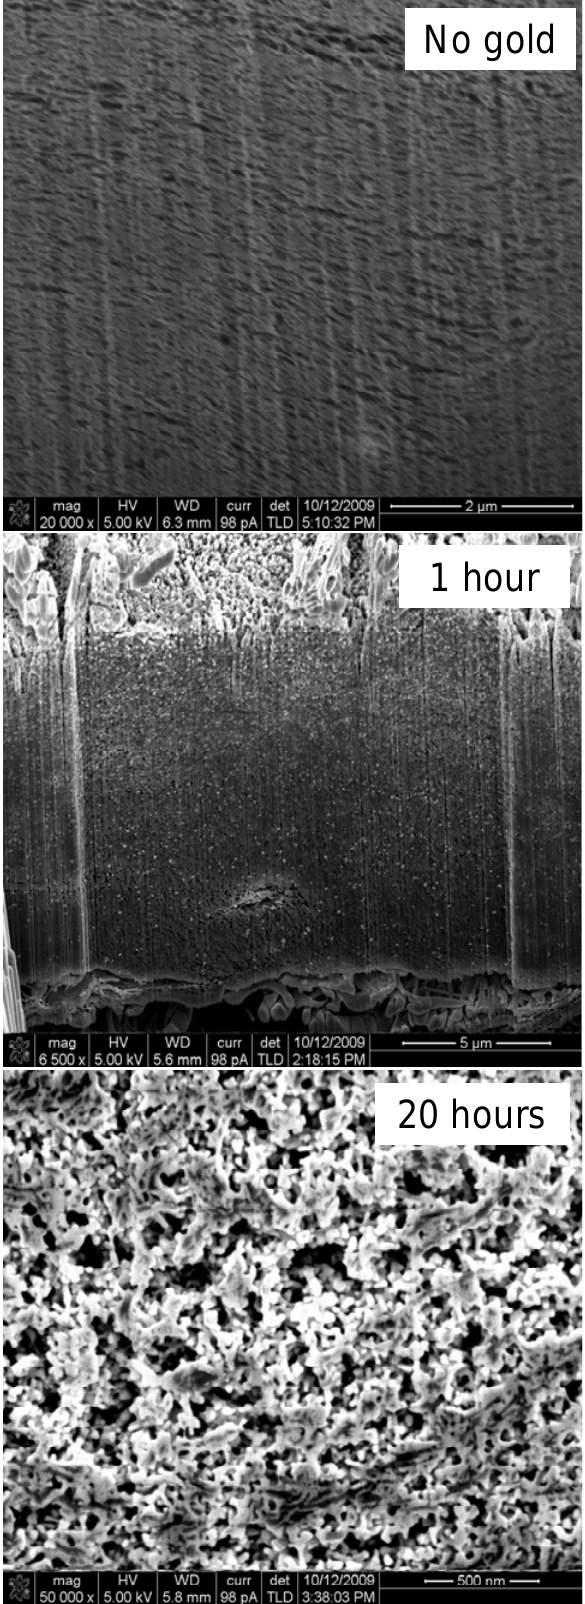
Figure 4. Scanning Electron Micrographs taken on a Focus Ion Beam (FIB) SEM. Cross sections were performed at an intensity of 7 nA and images taken at a tilt angle of 53°. The working distance was 7.5 mm and the surface was not coated with any conducting